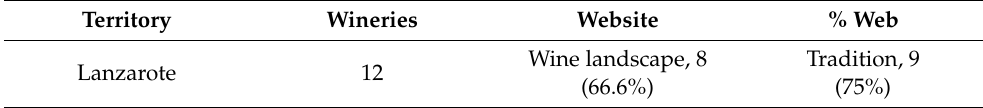
Table 7. Wineries of the Ribeira Sacra and Lanzarote AOs with a website.